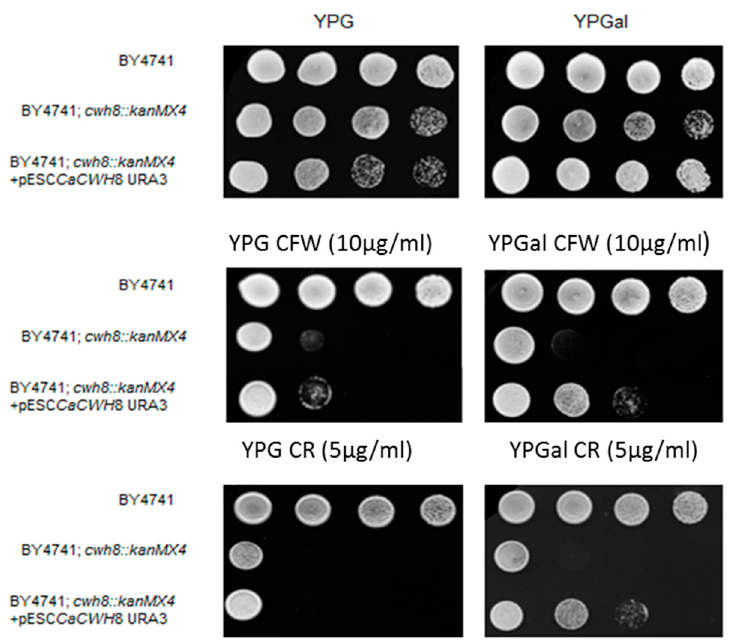
Figure 1. C. albicans CWH8 gene partially restores resistance of S. cerevisiae BY4741 cwh8: kanMX4 to Calcofluor White and Congo Red.